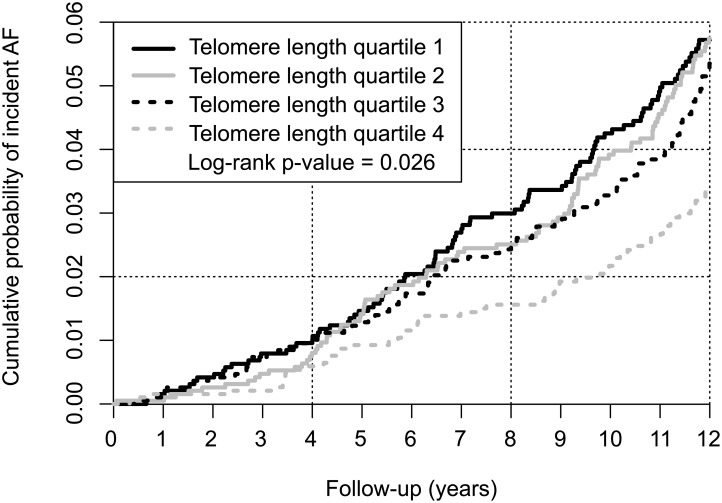
Cumulative incidence curve of incident AF, by quartiles of leukocyte telomere length.Quartile 1 represents the shortest telomere length group. Quartile 4 represents the longest telomere length group.